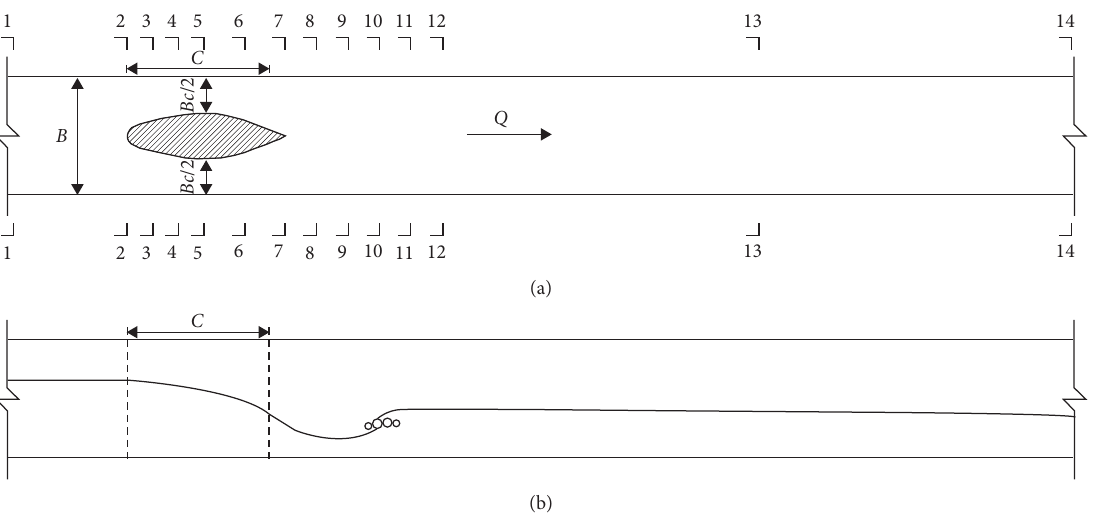
Figure 2: The (a) plan-view and (b) profile-view of a portable pillar-shaped